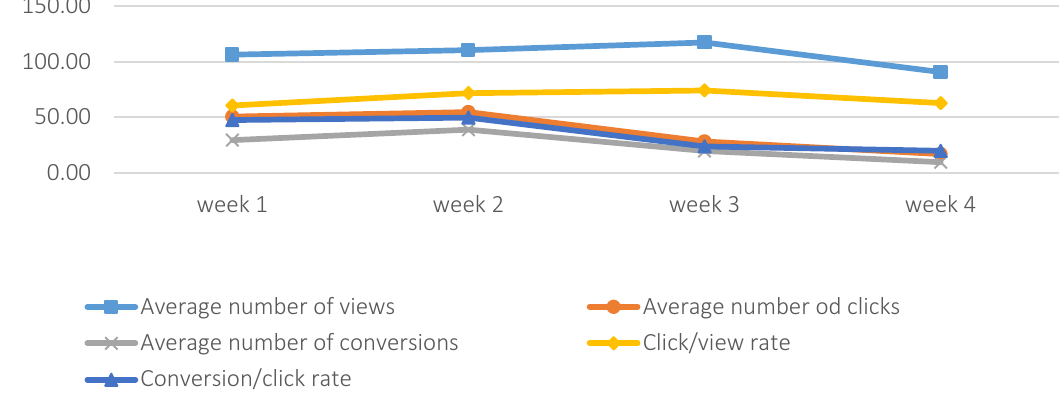
Figure 4. Retargeting performance development over